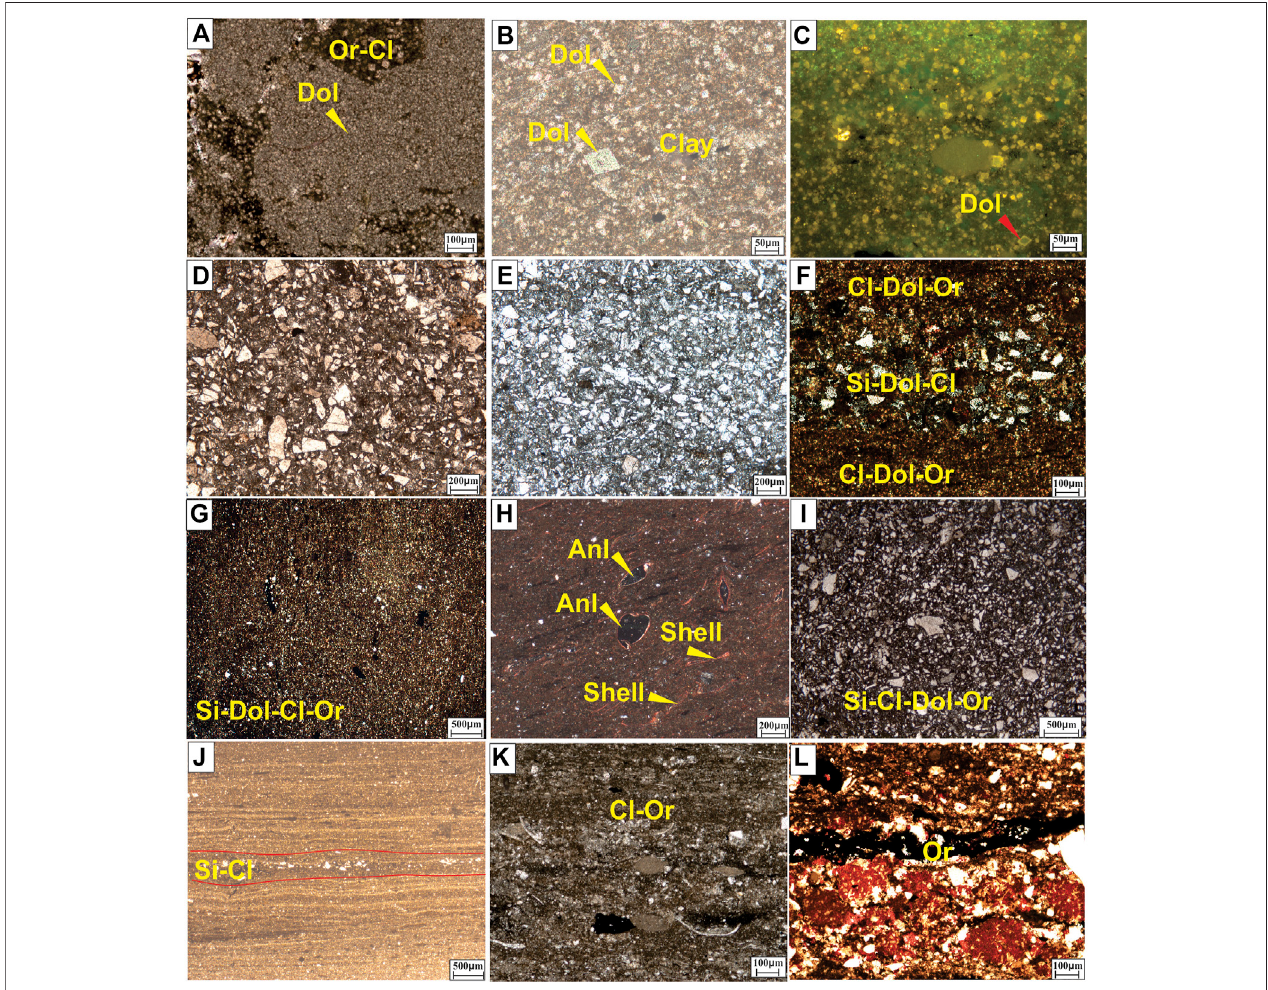
FIGURE 2 | The characteristics of fi ne-grained mixed sedimentary rock of Ek 2 lacustrine shale in the Congdong Sag (A) . Fine-crystalline dolomite, with mixed organic matter and clay minerals. (B) . Fine-crystal-medium-crystal dolomite is mixed with clay minerals (C) . Fine-grained-medium-crystalline dolomite is mixed with clay minerals,andagoodoil-bearingdisplaycanbeseenunder fl uorescence (D) .Shalewithalargeamountofquartz,feldspar,clayminerals,mixeddeposits. (E) shalewitha lot of quartz and feldspar (F) . Layered structure, medium-coarse feldspar-quartz particles are layered. Clay minerals and fi ne-grained dolomite layers (G) . Mixed shale, mixed deposition (H) . Mixed shale, mixed deposition. Visible biological shells. Shells are fi lled with analcime (I) . Mixed shale, mixed deposition (J) . Fine-grained felsic and clay laminae, with a coarse-grained felsic layer in the middle (K) . Fine-grained mixed sedimentation, with clay minerals-organic matter layer, shell and felsic in disorderly distribution. l: Calcite laminae-organic matter laminae, showing the messy distribution of felsic-dolomite. Ca-carbonate minerals; Si- felsic minerals; Cl-clay minerals; Anl- analcime; Or-organic matter.